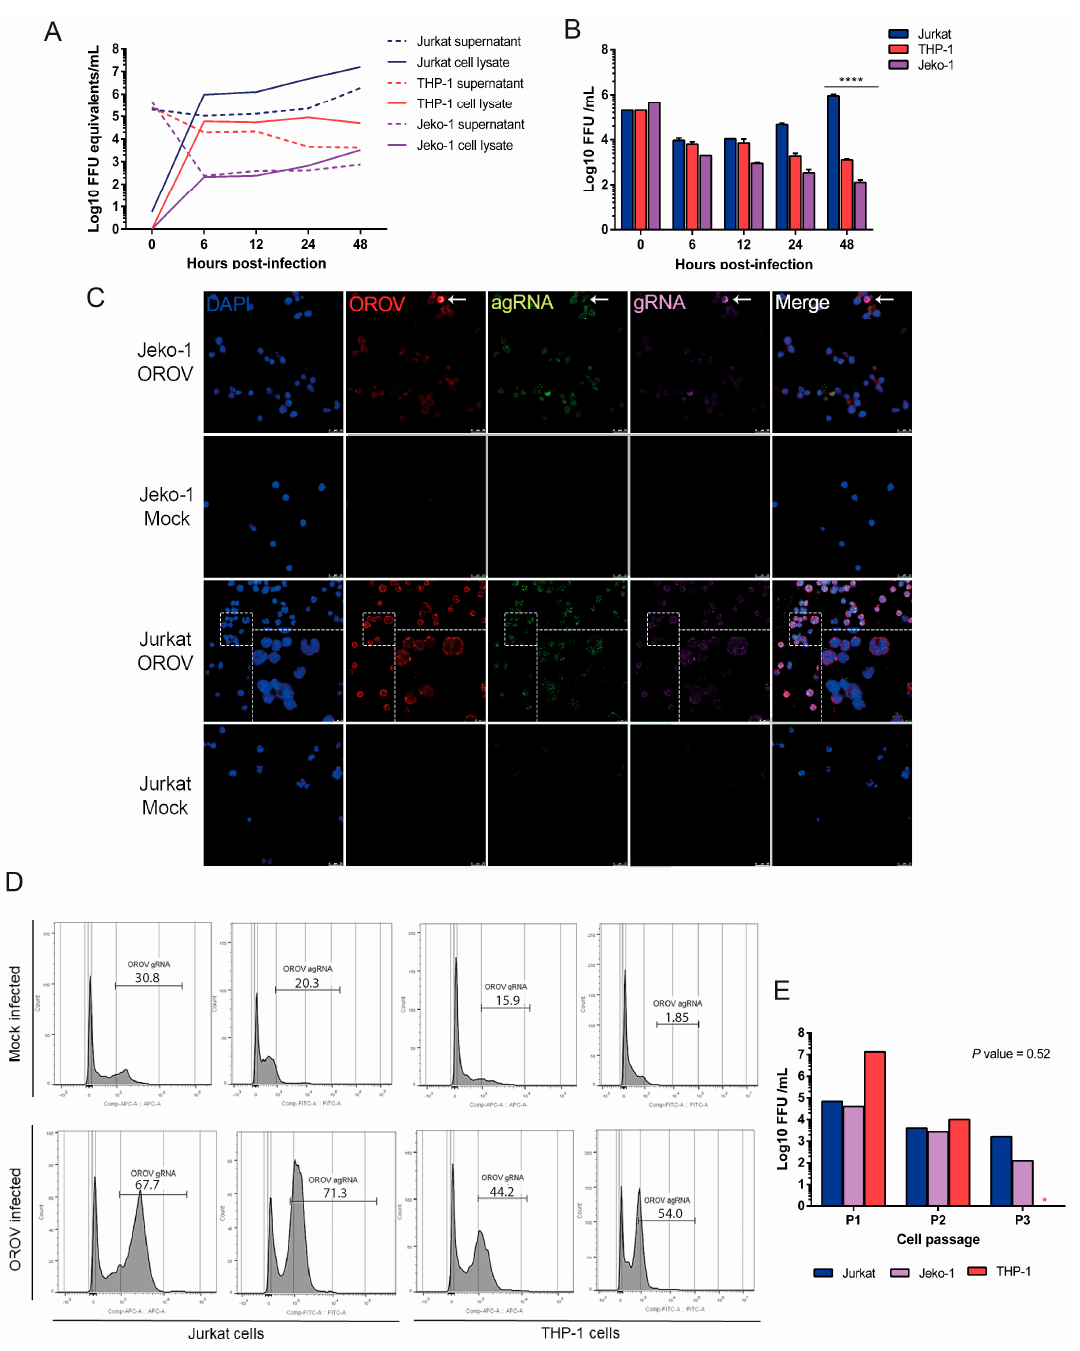
Figure 2. OROV productively infect di ff erent human leucocyte lineages. Jurkat, THP-1 and Jeko-1 cells were seeded in 24-well plates and infected with OROV. Cells, supernatants and cell lysates were collected for evaluation by di ff erent methodologies. ( A ) Infection at MOI 1 and OROV RNA measured in cellular lysates and supernatants by qRT-PCR for OROV segment S. Lines represent the mean of viral load ± SEM ( B ) FFA analysis of the supernatants. Jurkat cells’ productive viral replication